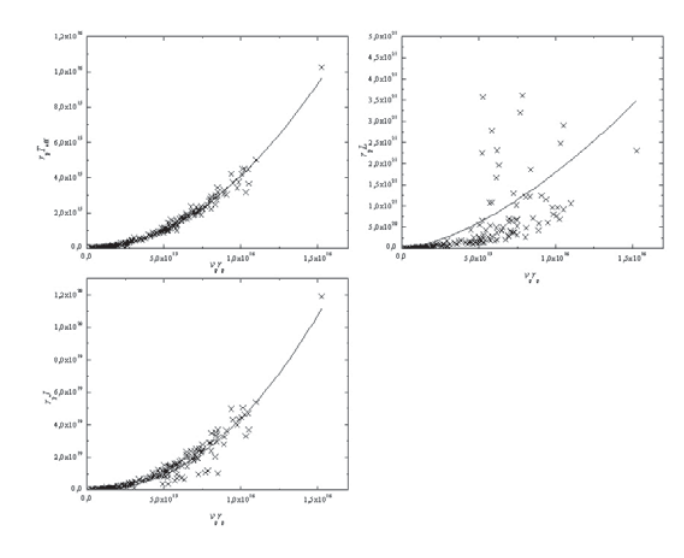
Fig. 2. Dependence of the parameters r p T e ff , r p L , and r p J on the parameter v p r p for the stellar spectral class G. According to the regression analysis, the best is the power interpolation with the coe ffi cient of determination R 2 = 0 . 983 for the parameter r p T e ff .